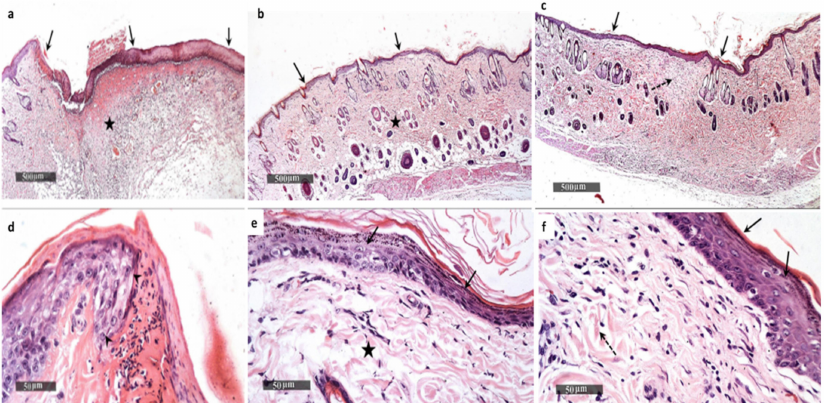
Figure 15. Histological examination of the wounds of rats on the seventh day. The control group ( a , d ) showed the presence of a wide area of epidermal loss in addition to ulceration in the wound gap (black arrow) with adjacent thickening in the epidermis (arrowhead). There was a highly cellular granulation tissue that is rich in inflammatory cells (black star). The Betadine™ group ( b , e ) showed an intact thin epidermal layer with intact keratinocytes and subcellular details (arrow). There was an intact layer of the dermis with a normal distribution of cellular elements and abundant well-organized collagen fibers (black star). The AgNPs group ( c , f ) showed efficient wound healing with complete epidermal re-epithelialization as well as wound closure (black arrow). There was more abundant fibroblastic activity with dermal granulation tissue rich in collagen (dashed